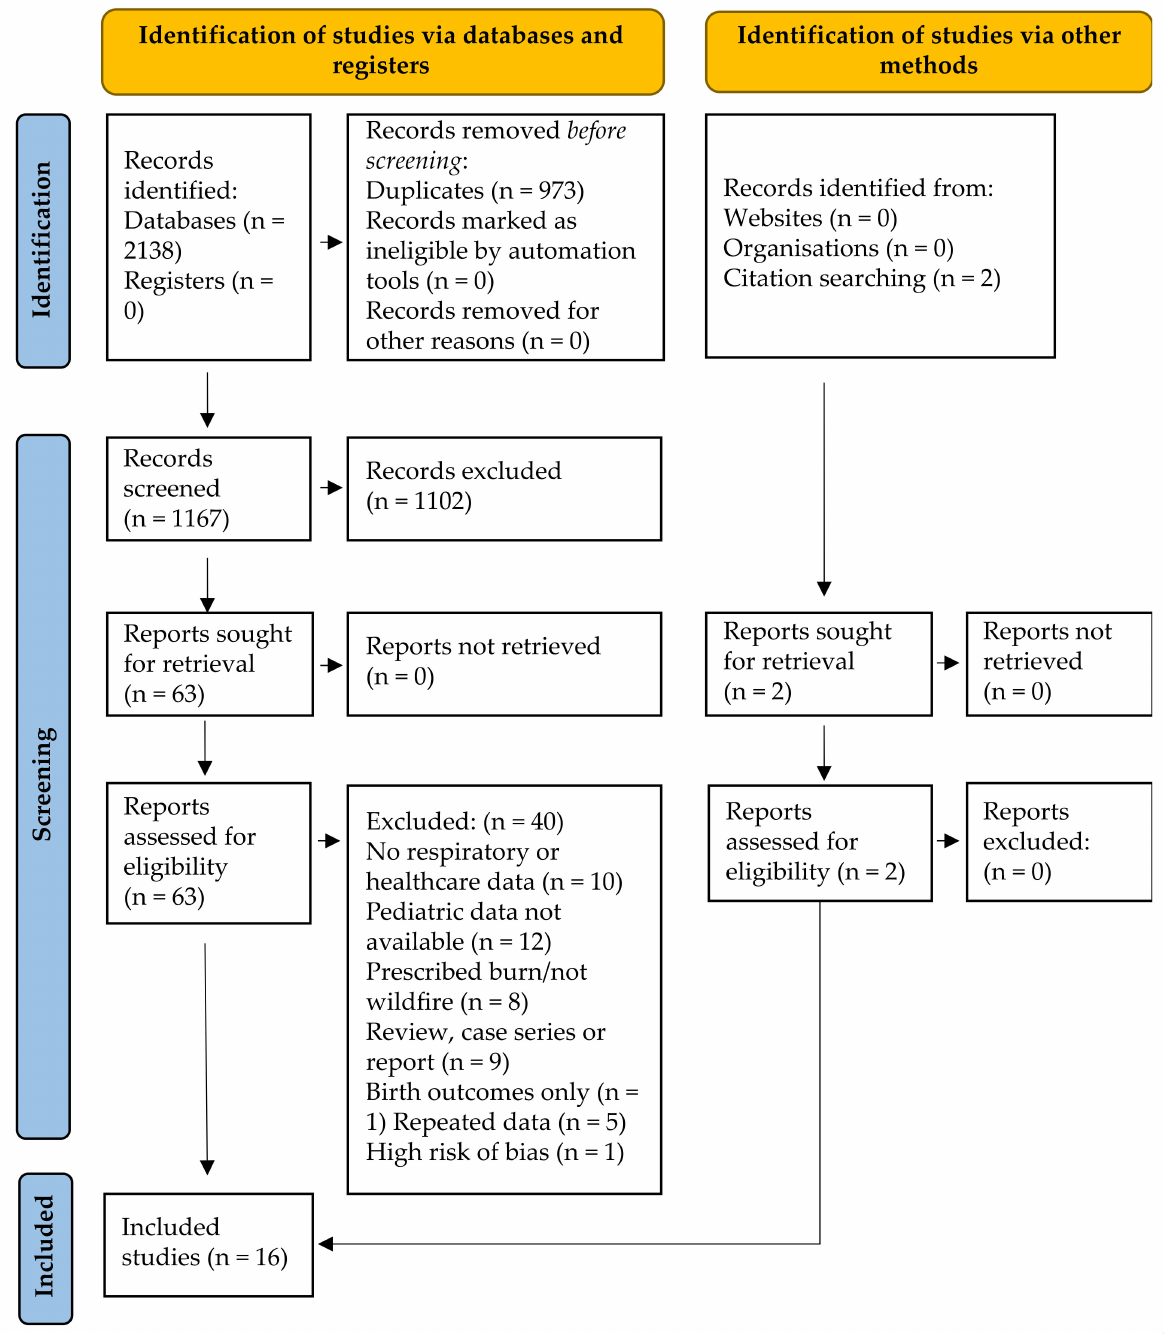
Figure 1. Modified PRISMA flow diagram [20] for pediatric outcomes associated with wildfire smoke exposure resulting from searches of databases, registers and other